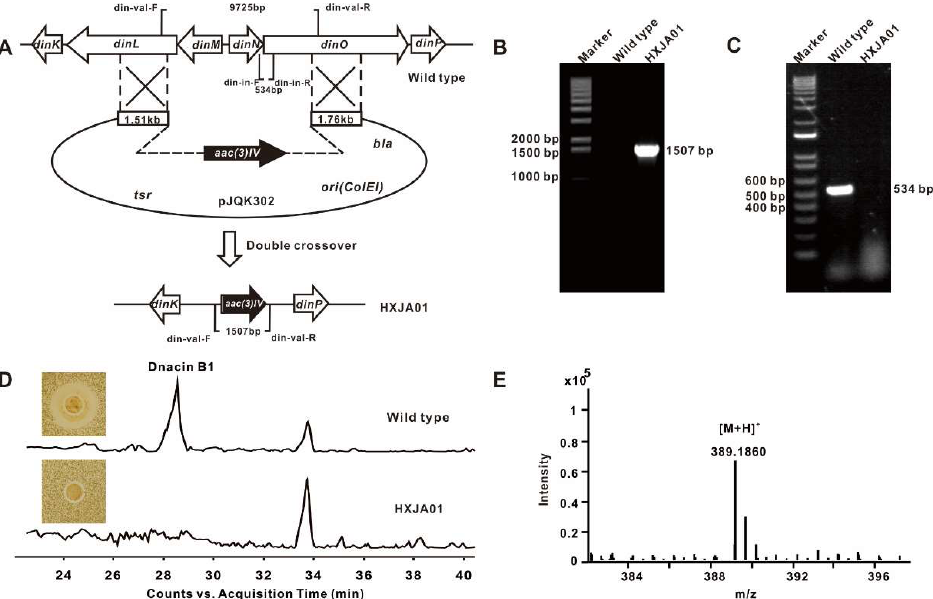
Figure 2. Inactivation of dnacin B1 BGC. ( A ) Construction of the dnacin B1 BGC inactivation mutant by homologous recombination. ( B ) PCR validation of wild type and mutant HXJA01. When using din-val-F/R as primers, the product of mutant HXJA01 was 1507 bp, whereas there was no product in wild type. ( C ) PCR analysis of wild type and mutant HXJA01. When using din-in-F/R as primers, the product of wild type was 534 bp, whereas there was no product in mutant HXJA01. ( D ) HPLC-MS and bioassay analysis of wild type and mutant HXJA01. ( E ) HR-ESI-MS analysis result of the dnacin